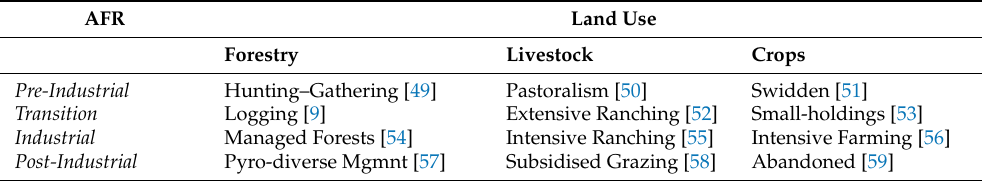
Table 1. Indicative land management practices used to structure literature review with exemplary